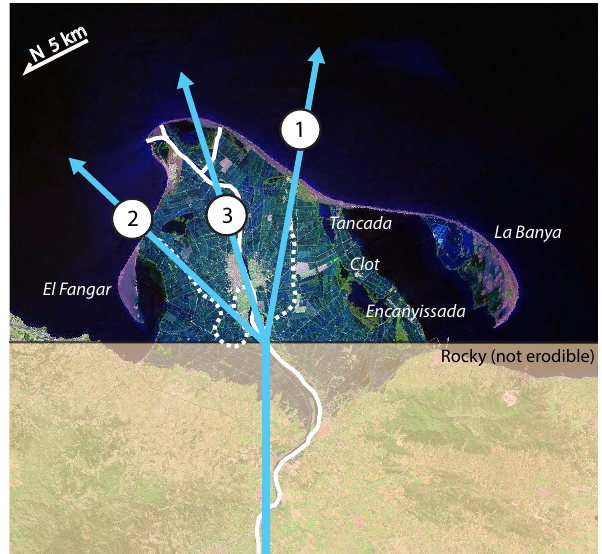
Figure 2. Schematic of modeling scenario, highlighting the suc- cession and orientation of Ebro Delta lobes, shown on top of the modern morphology (NASA Landsat image) and the inferred paleo- channels (dotted lines, from Maldonado, 1975). In the model, the straight reference coastline is assumed to be non-erodible. Names refer to the spits and the lagoons on the Ebro Delta. Numbers refer to the (1) Riet Vell, (2) Sol de Riu, and the (3) Mitjorn-Buda lobes.